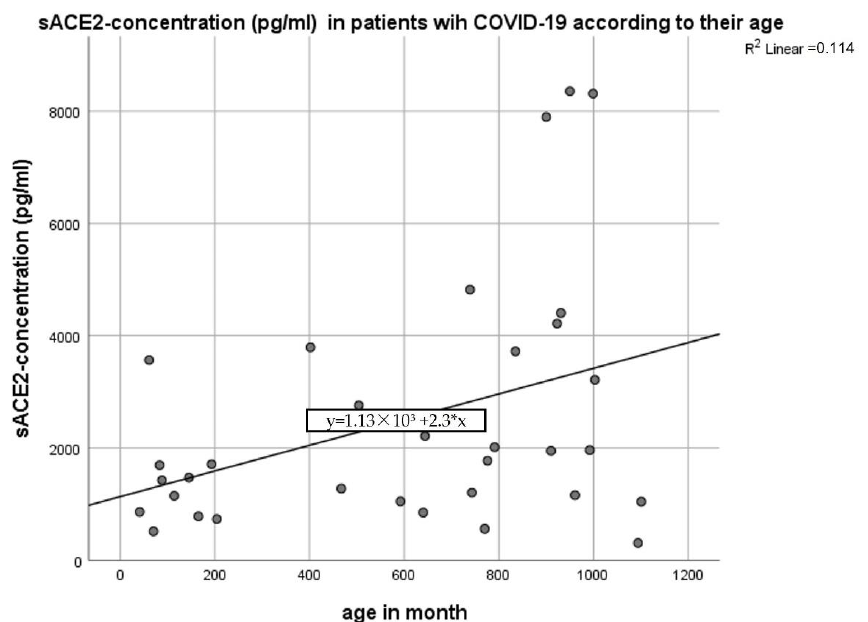
Figure 2. Correlation of sACE2 concentration (pg/mL) and raising age (in month) in patients with COVID-19, linear multivariate regression analysis (age and sex), p = 0.03 .